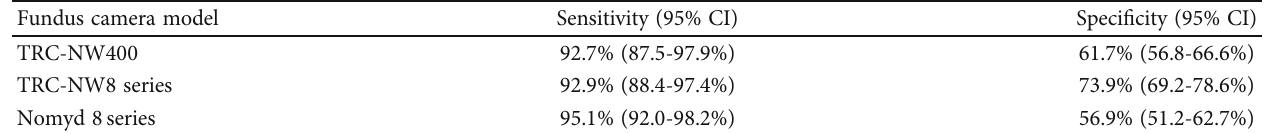
Table 3: Sensitivity and speci fi city of VeriSee DR in diagnosing any DR in three di ff erent camera models.